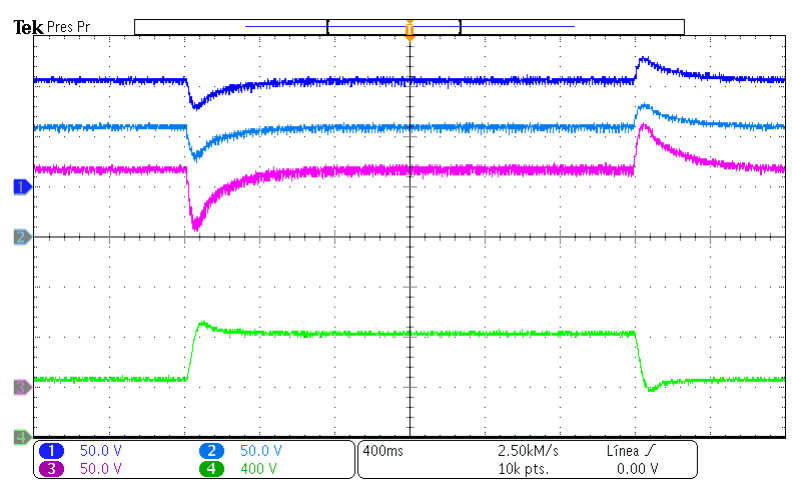
Figure 14. Transient responses during NLL stepwise changes of: (CH1) the capacitor voltage v C 1 (y-axis 50 V/div); (CH2) the capacitor voltage v C 2 (y-axis 50 V/div); (CH3) the sum of the capacitors voltages x 2 (y-axis 50 V/div); and (CH4) the power reference p ∗ calculated in the regulation loop (y-axis 400 W/div).